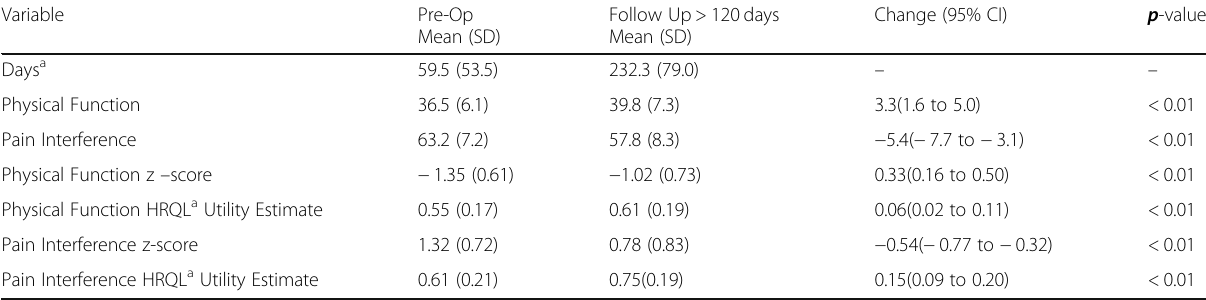
Table 1 Mean pre-op and follow up physical function and pain interference variables for patients with pre-op and follow up data greater than 120 days ( n = 68)